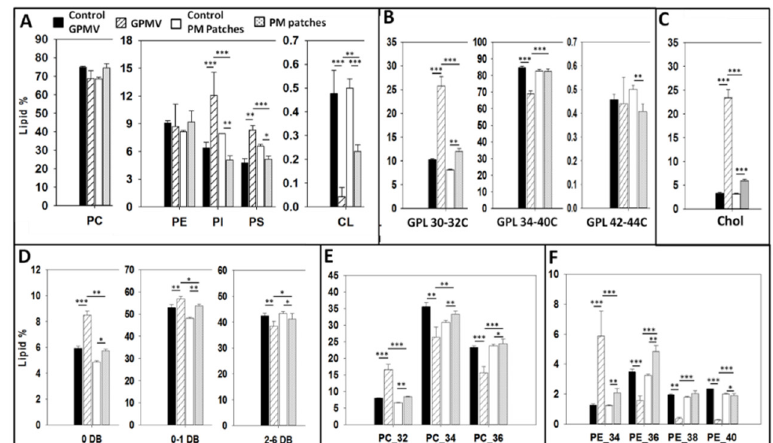
Figure 6. Mass spectroscopy lipidomic analysis of whole cells and plasma membrane preparations.